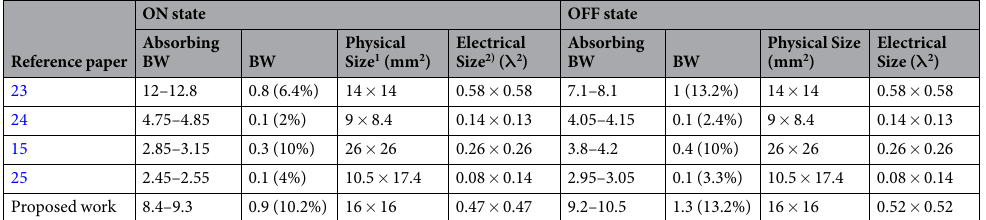
Table 1. Comparison of the proposed metamaterial absorber using PIN diode with other researches. [unit: GHz]. 1) Physical Size of the unit cell. 2) Electri cal Size is calcualted at the center frequency of the absorbing